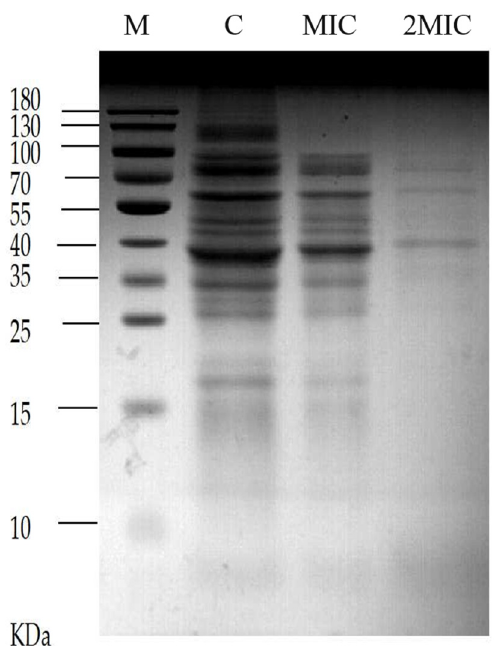
Figure 6. Effect of MA on soluble protein of S. aureus. Note: M = Marker, C = Control group.